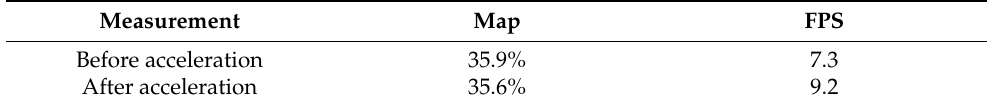
Table 3. Network acceleration test